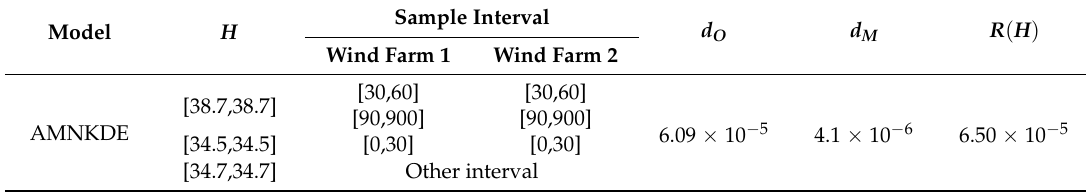
Table 1. Detailed calculation results of JPDF for Wind Farms 1 and 2 by AMNKDE.